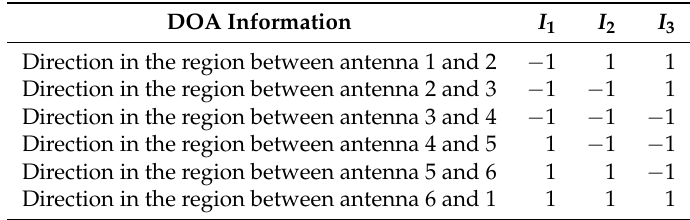
Table 1. Details of MD for modified C-MRCJ.